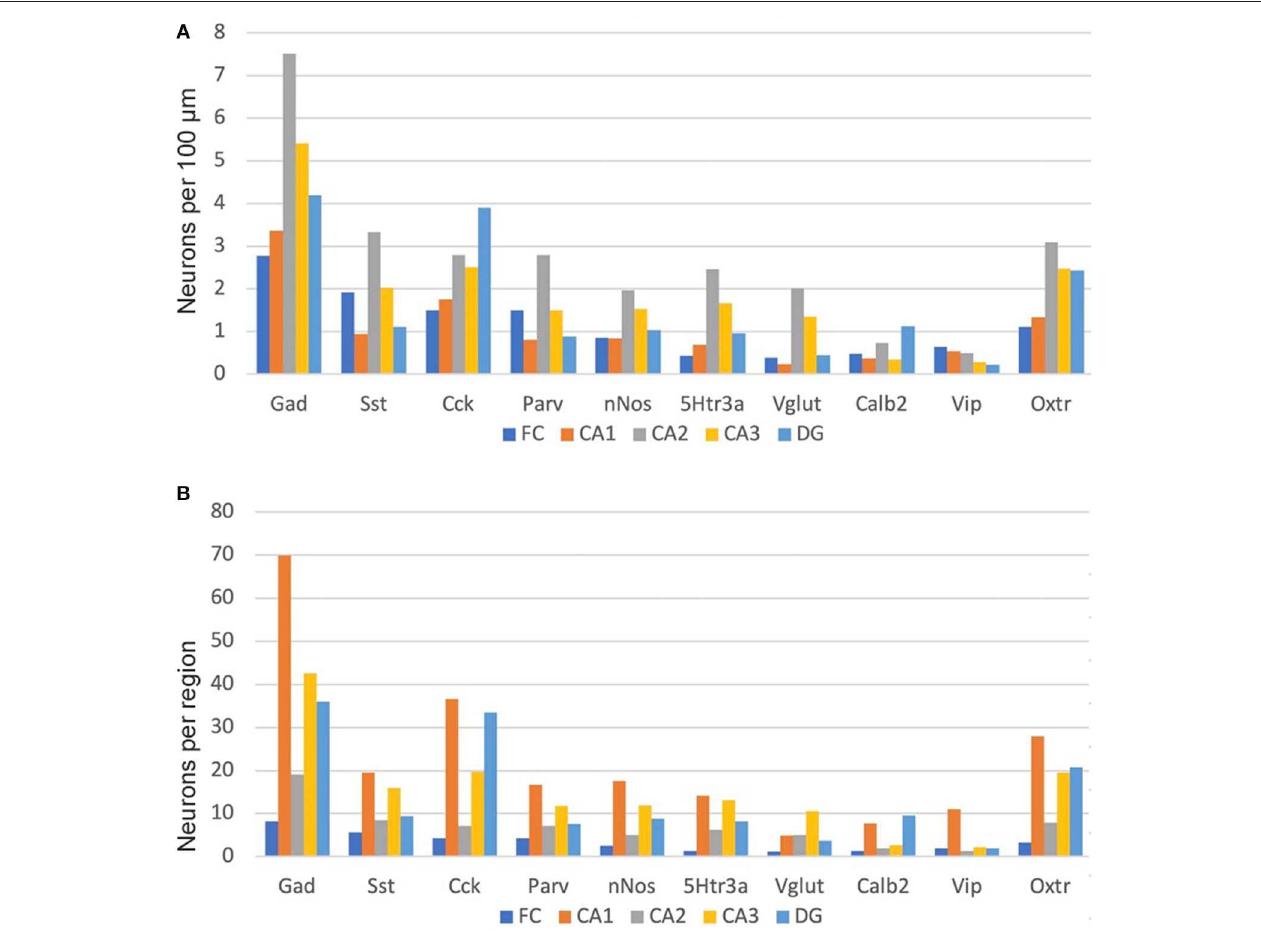
FIGURE 9 | Interneuron types per length in the hippocampal regions (A) and, as well, as per total hippocampal region area (B) . See the Methods and Methods for the measured lengths and calculations. Cck and Oxtr neurons in the PCL of FC, CA2, and CA3 were counted if they co-expressed